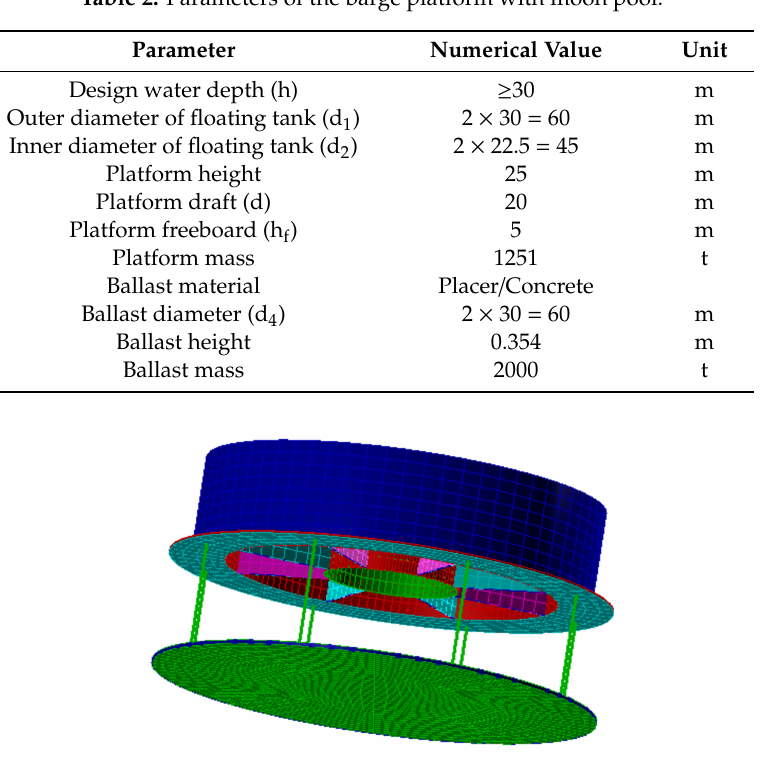
Figure 5. Panel model of the air-cushion-supported barge floating